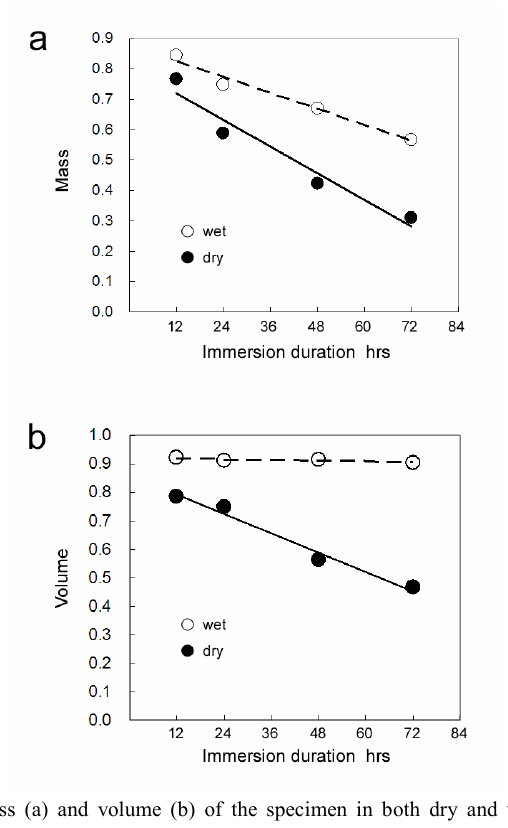
durations decrease with increasing demineralization.